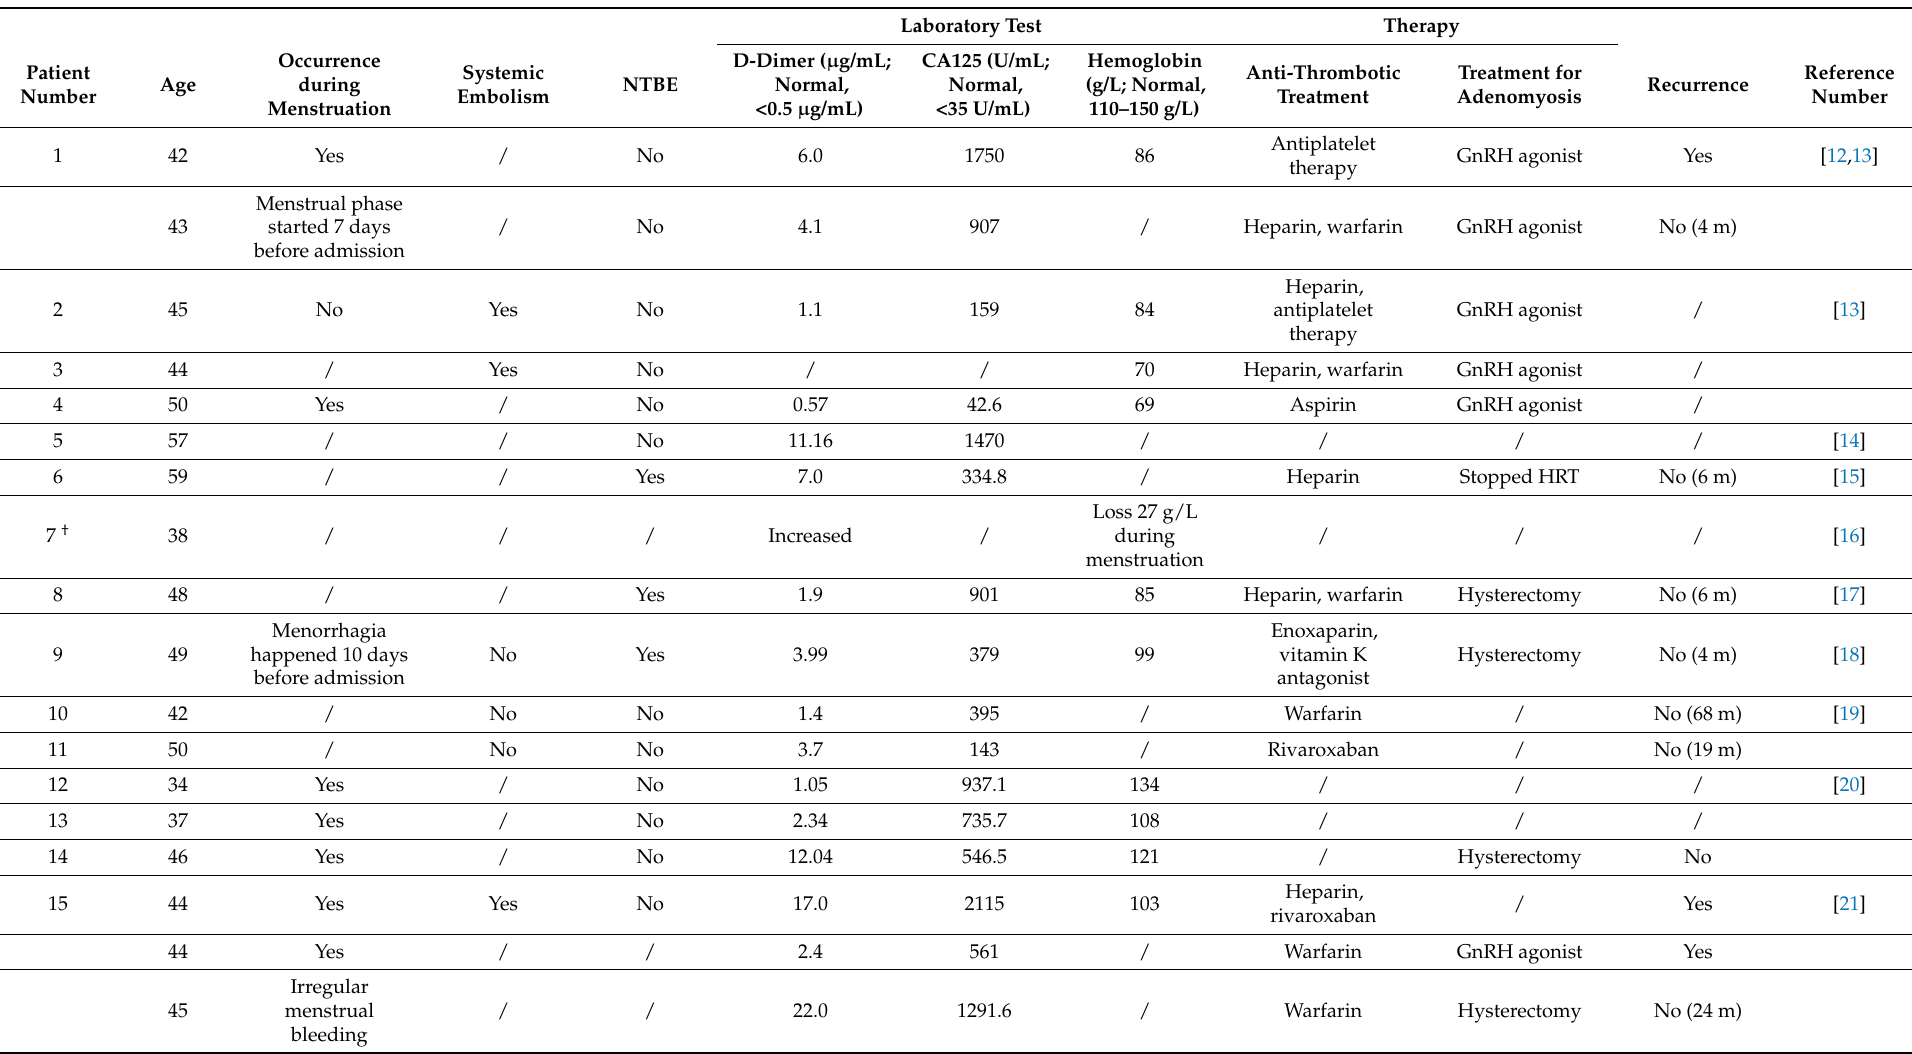
Table 1. Reported cases of adenomyosis-associated ischemic